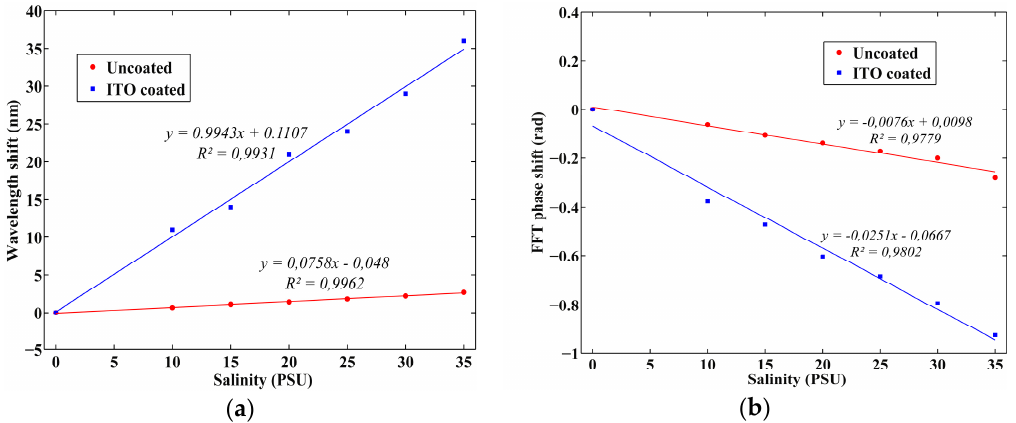
Figure 3. ( a ) Wavelength shift with saline concentration; ( b ) Phase shift with saline